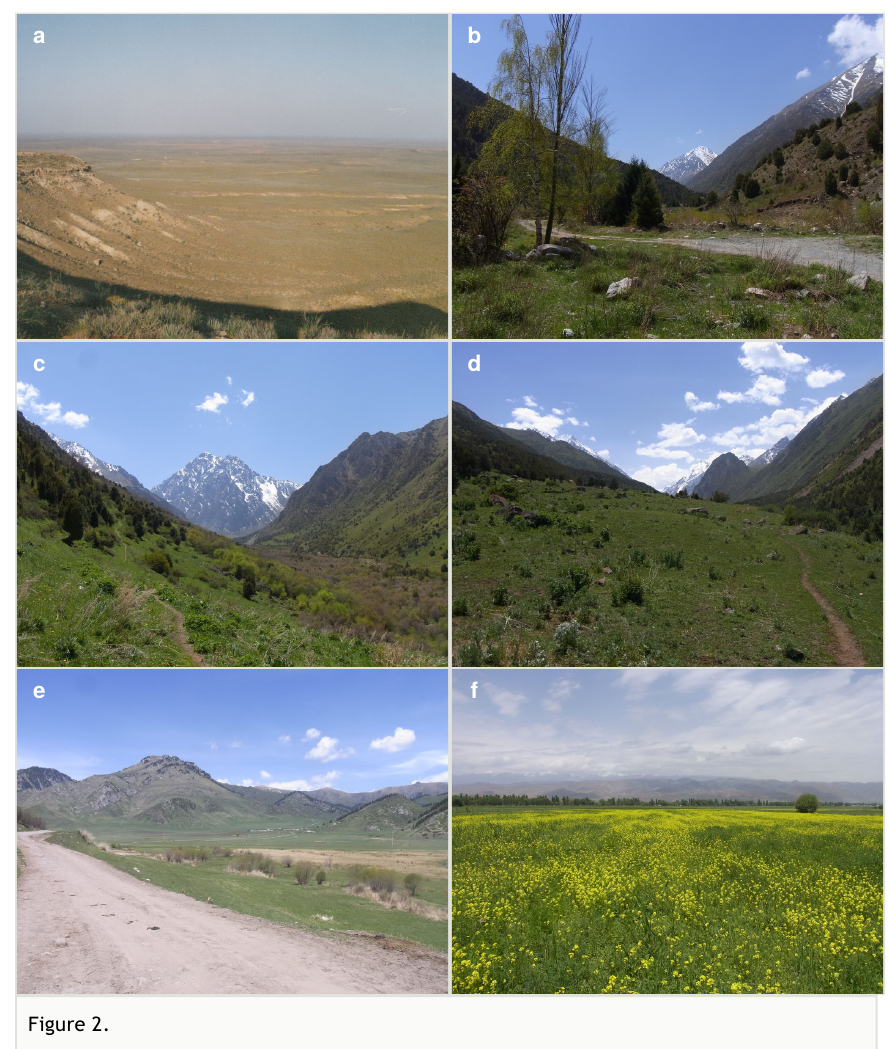
Figure 2. Collecting